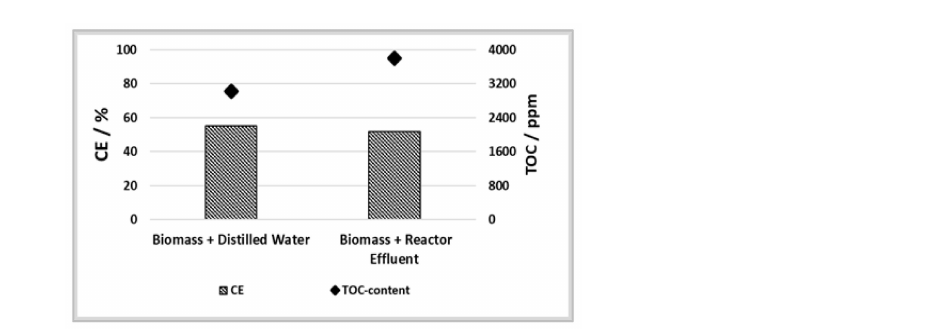
Figure 8. Carbon efficiency and TOC content of reactor effluent of gasification experiments with grapevines for two different feeds. Table 6. Organics in reactor effluents of the experiments with grapevines (in mg L − 1 ). Effluent of